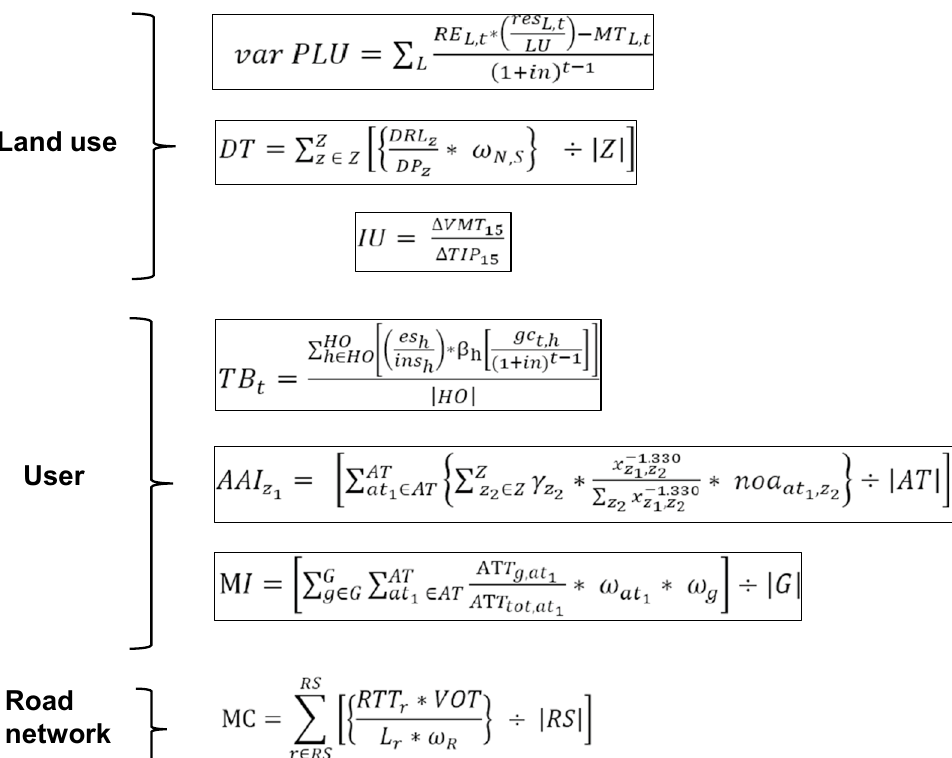
Fig. 2 Indices for three different classes used for quantification of penetration